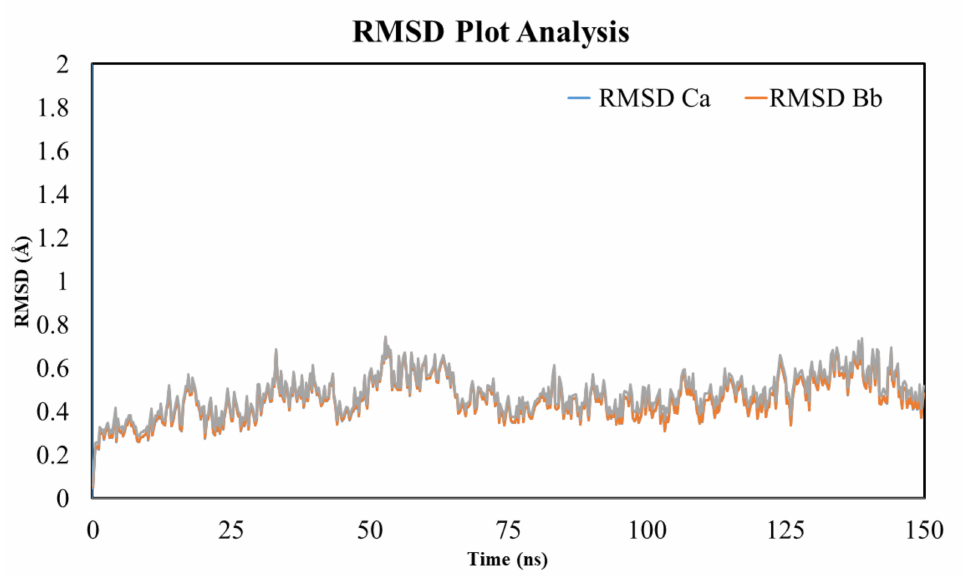
Figure 8. The MD simulation analysis using the root mean square deviation (RMSD) plot. The MD simulation was performed to assess the RMSD value of the TLR-4 and rutin complex for 150 ns. The MD simulation analysis showed a RMSD score within the acceptable range and no significant deviation was